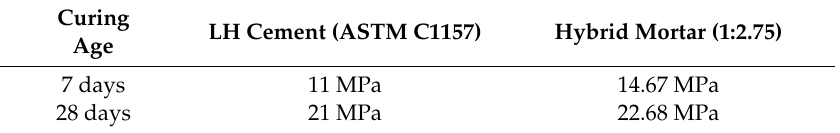
Table 5. Compressive strength required by the ASTM C1157 (NTC 121) standard for a LH type